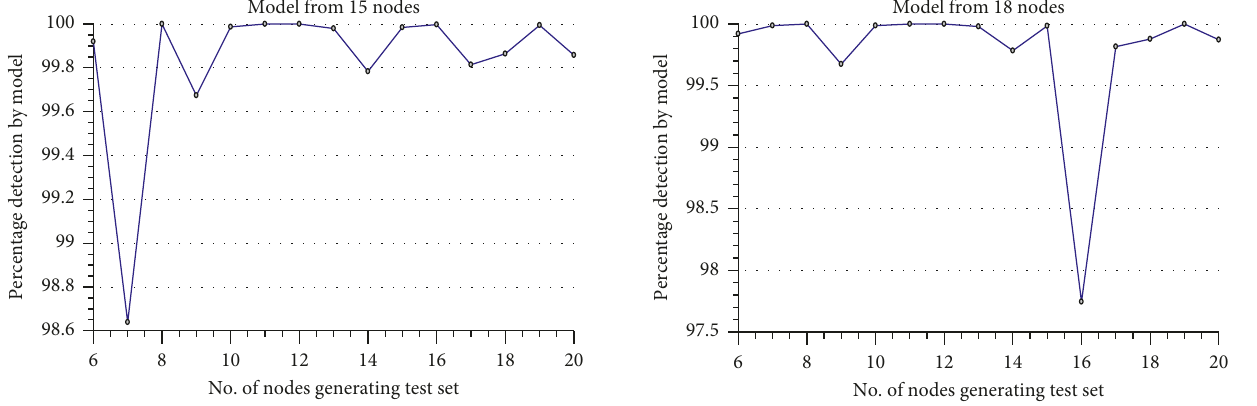
Figure 20: Simulation results for 18